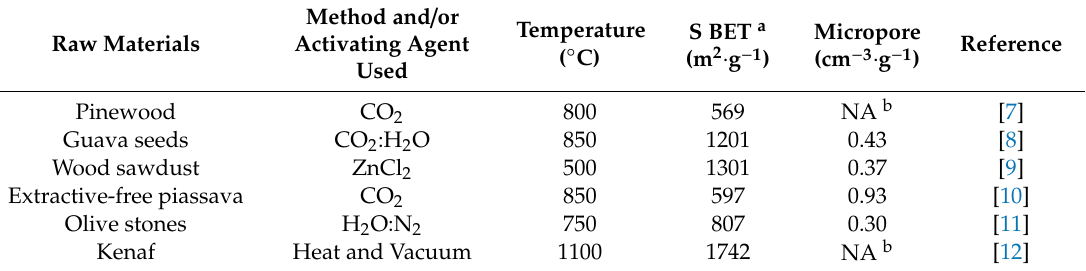
Table 1. Summary of activation conditions, surface area characteristics (SBET) and micropore volume of di ff erent activated